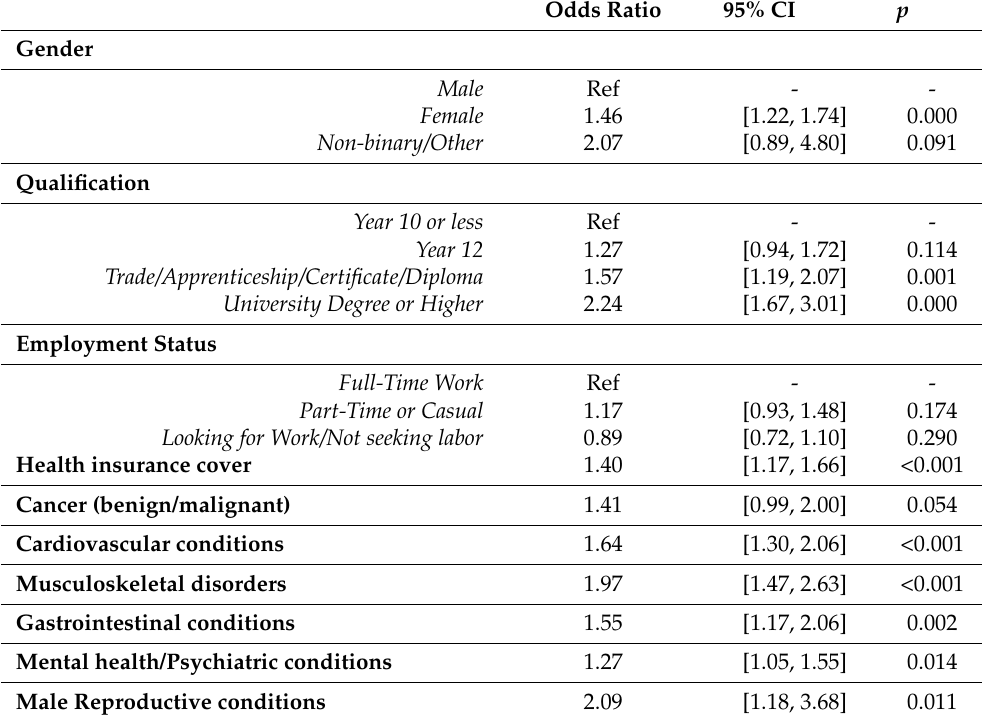
Table 3. Characteristics predicting oral CM product use.